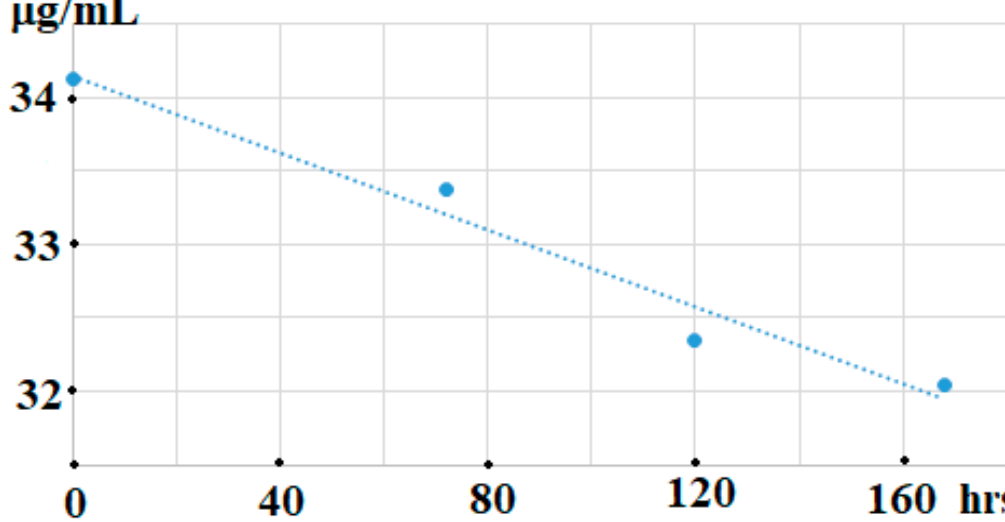
Figure 2. The concentrations (µg/mL) of OAc in ovine milk stored at 23 °C for 168 h (injection volumes: 6 µL).